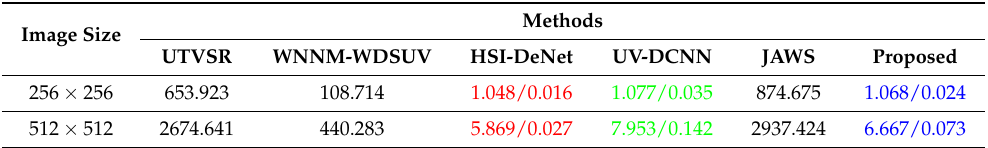
Table 3. Average computation time (Unit: Seconds) comparison on different image size. For learning- based methods, the computation times on CPU/GPU are both presented.